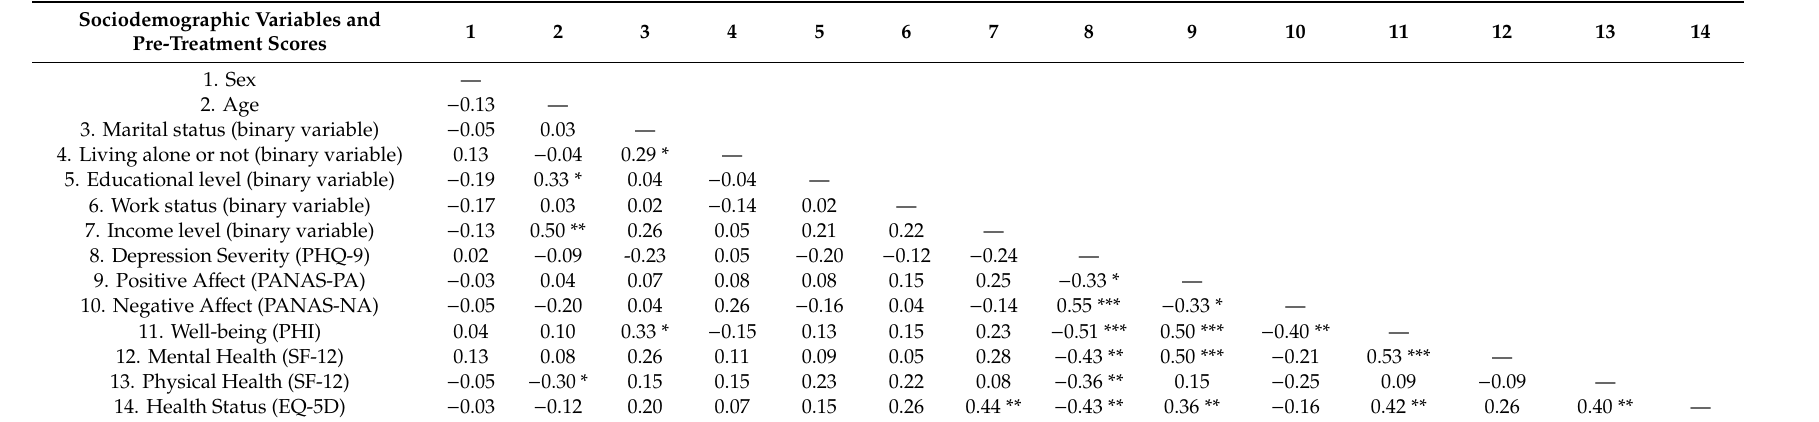
Table 4. Point-Biserial and Pearson’s correlations between proposed predictor variables.